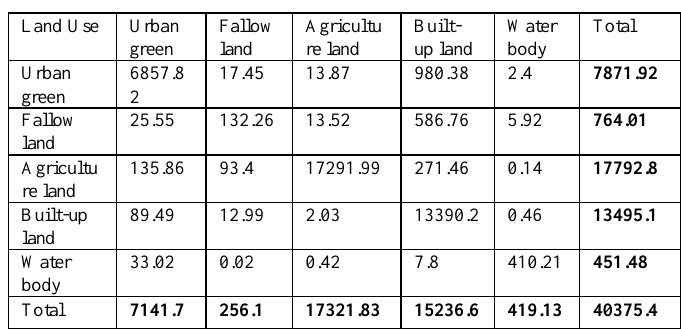
Figure 8: Change in Agricultural Land (2008-15)